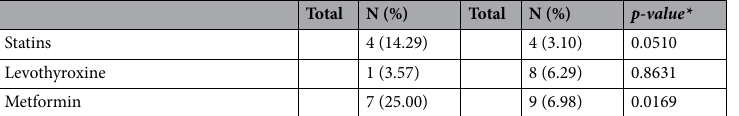
Table 1. Epidemiological and demographic description of 213 individuals enrolled on the case–control study. * p-values for Fisher’s Exact test. ** p-values for Wilcoxon Signed Rank test. Significance after Bonferroni adjustment for multiple comparisons (α = 0.001) is represented in bold .